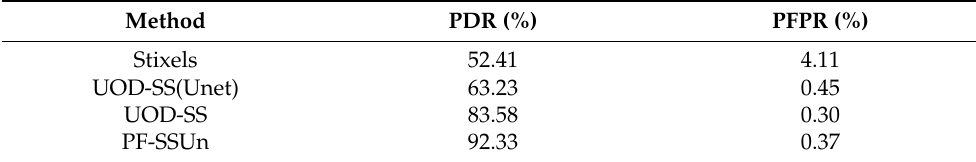
Table 1. Comparison of performance indicators of the four detection methods.